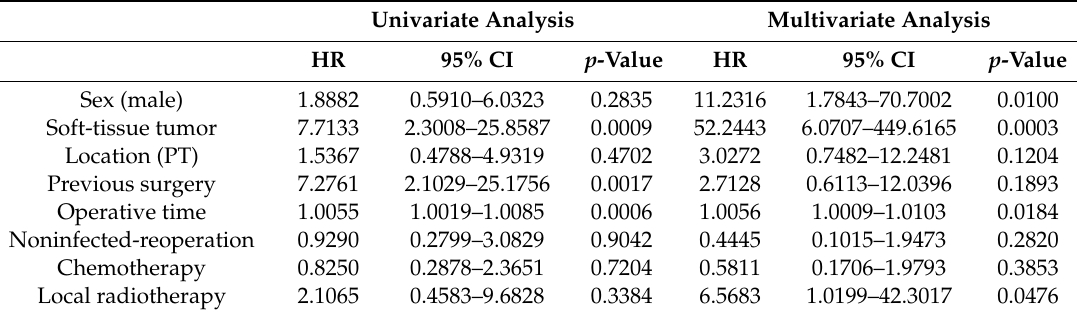
Table 4. Univariate and multivariate analyses of the risk factors of periprosthetic infection. Univariate